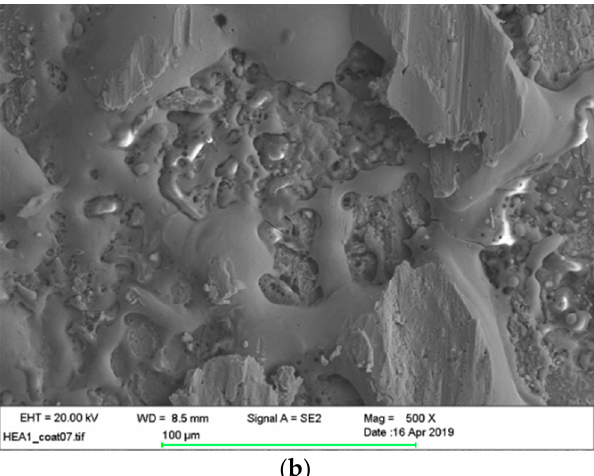
Figure 6. Surface view of the deposited CoCrFeNiMo coating; SEM images at ( a ) lower magnification and ( b ) higher magnification.